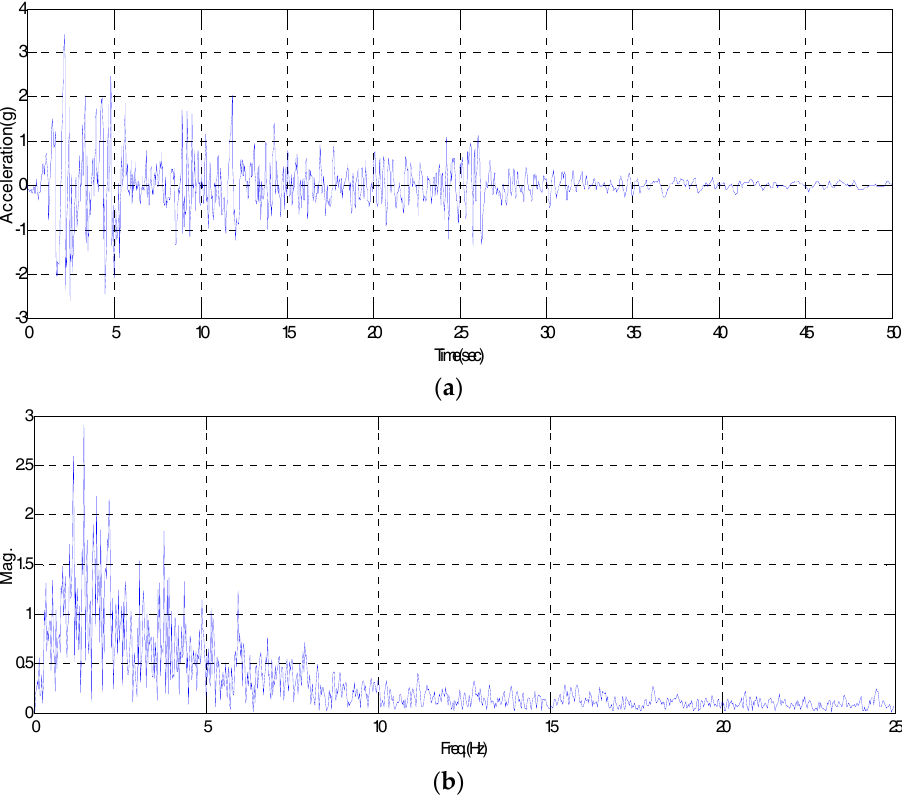
Figure 5. El-Centro seismic waveform for reference signal of AFB: ( a ) Time domain; ( b ) Frequency domain.